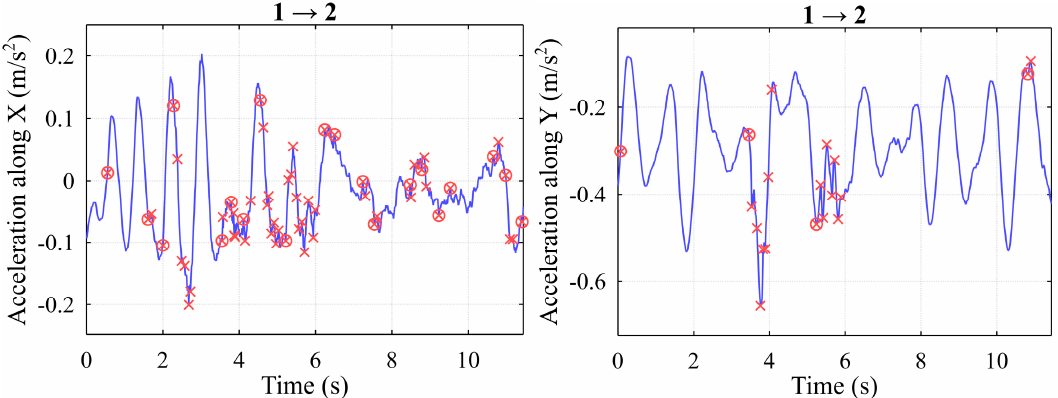
Figure 14. Use case No. 3 with the increased threshold (detected impacts: ( left ) 20; ( right ) 4). A 10% decrease resulted in the decrease in detected impacts along the X-axis by two (refer to Figure 15), and the number of impacts along the Y-axis decreased by four.